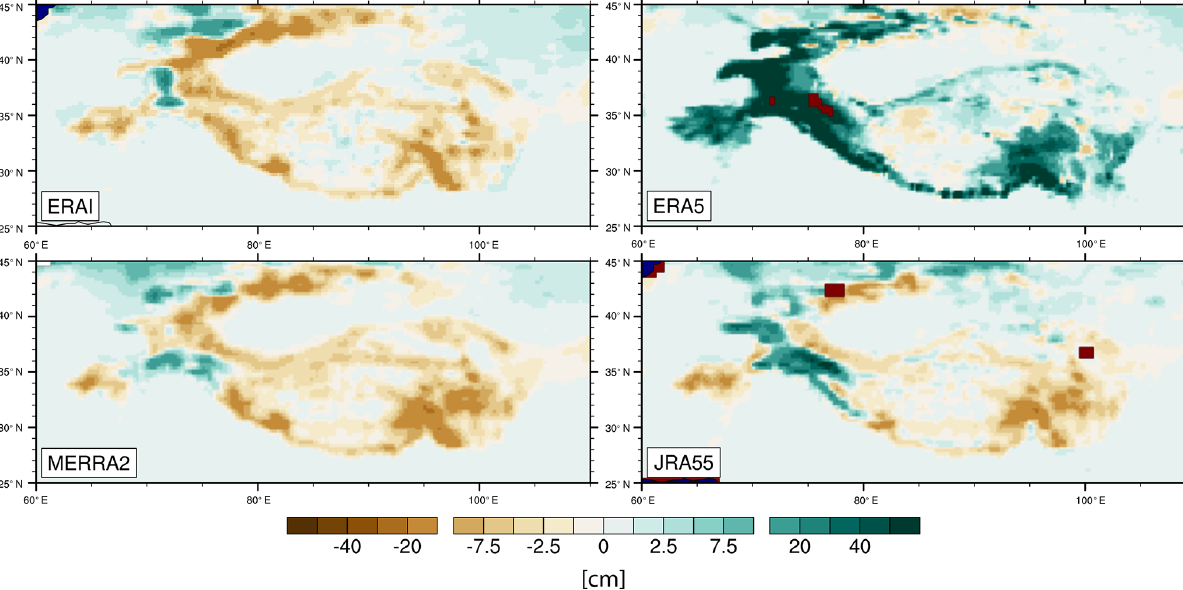
Figure 6. Maps of the 2-year mean SD January anomalies (in centimetres) from the satellite MW data for the years 2009 and 2010 over the TP region for each of the four reanalyses (ERA5, ERA-I, MERRA-2 and